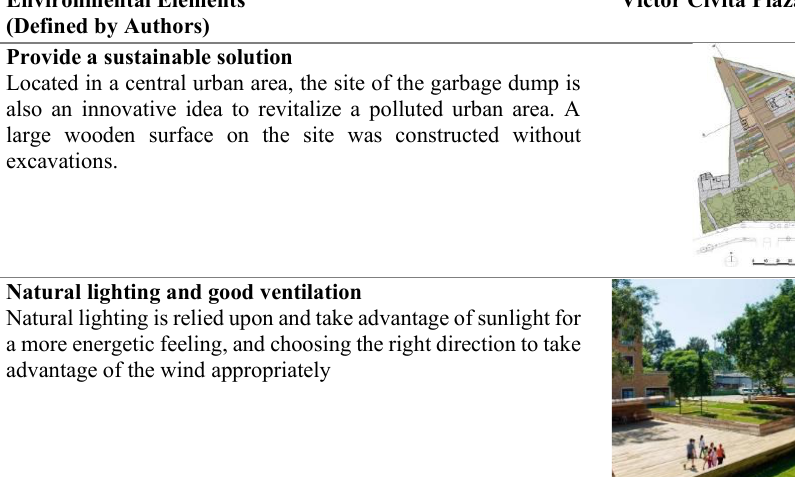
Table 4 : Selection of the most prominent environmental elements in "Victor Civita Plaza" (Analyzed by the authors) (Figures source: URL7) Environmental